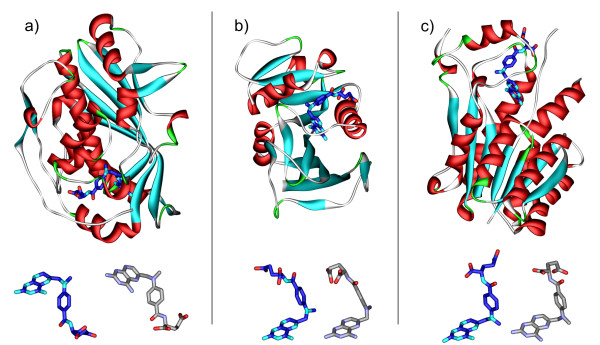
Methotrexate bound to different proteins. Three different proteins are shown in cartoon representation. The bound conformations of Methotrexate (coloured dark blue) is shown in stick representation. The lower figures show the bound conformations originating from crystal structure (left hand site) and most similar computed drug conformer (right hand site). a) Thymidilate synthase of Escherichia coli (PDB: 1AXW, chain A). b) Dihydrofolate reductase of Homo sapiens (PDB: 1DLS). c) Pteridine Reductase 2 from Trypanosoma cruzi (PDB: 1MXF, chain D)